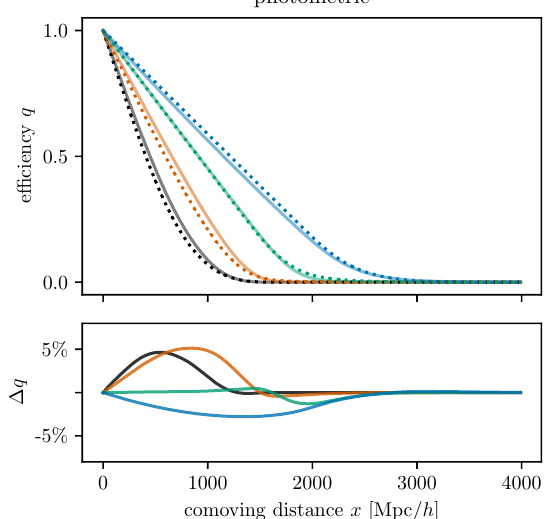
Figure 3. Number count histograms for intrinsic redshifts z intr ( top ) and photometric redshifts z phot ( bottom ) after selection of the photometric redshifts z tomo into nominal tomographic redshift bins ( dashed lines ).